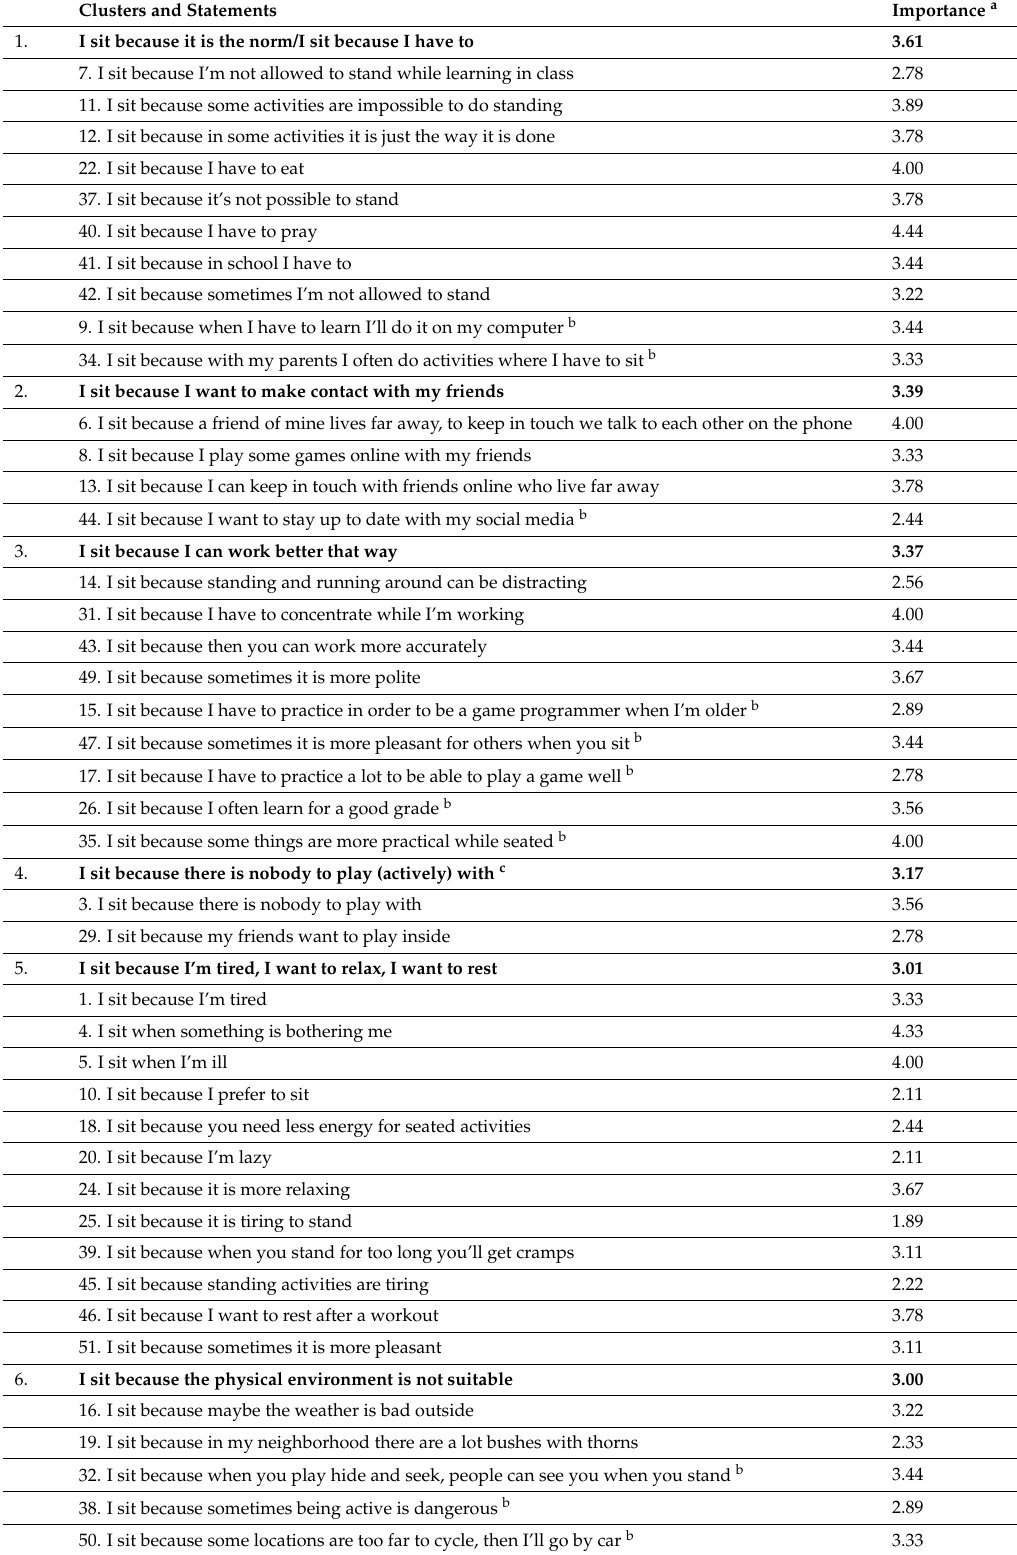
Table A10. Clusters, statements and importance ratings of children (school